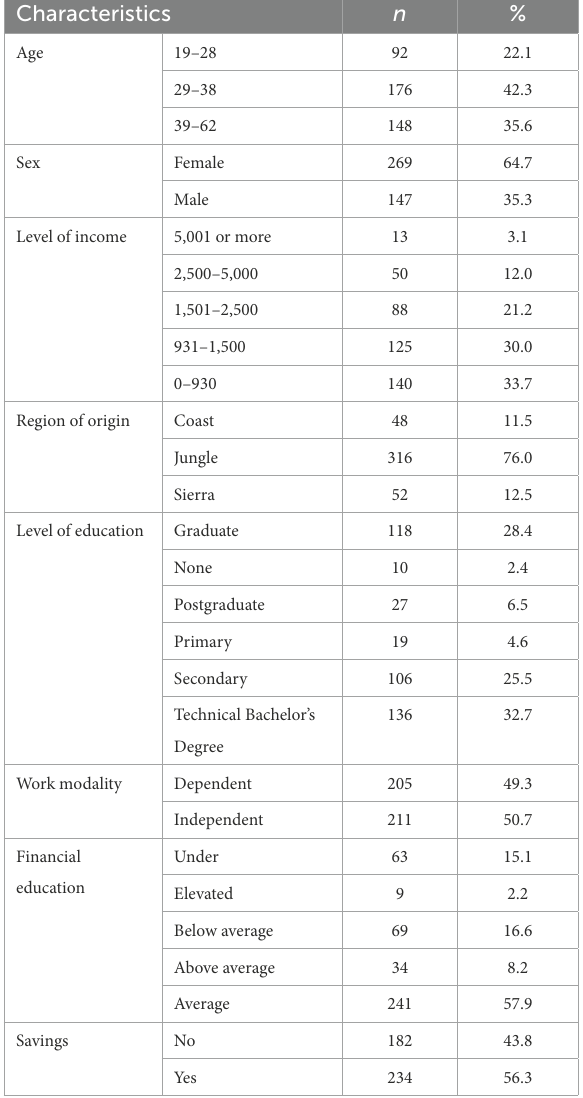
TABLE 1 Sociodemographic information.